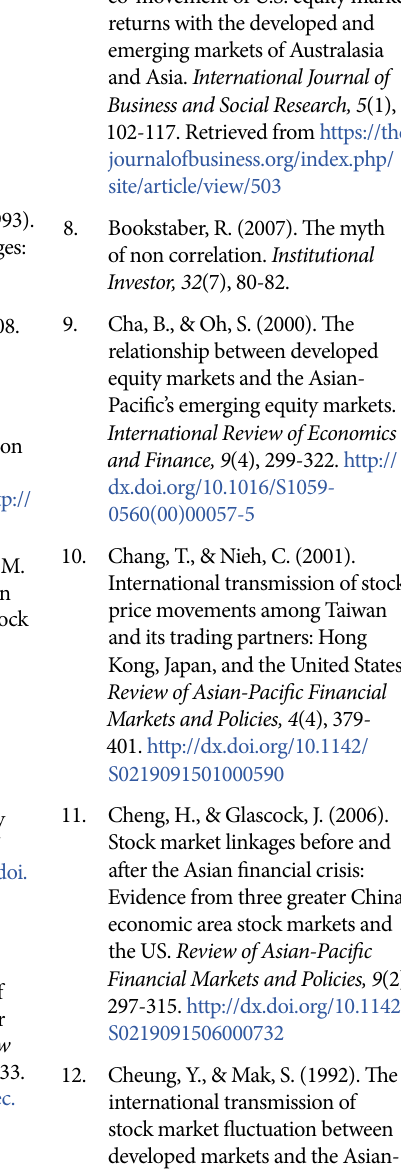
(2001). Equity market linkages in the Asia Pacific region: A comparison of the orthogonalized and generalized VAR approaches. Global Finance Journal, 12 (1), 1-33. Retrieved from https://ideas.repec. org/a/eee/glofin/v12y2001i1p1-33. html 15. Dimson, E. (1979). Risk measurement when shares are subject to infrequent